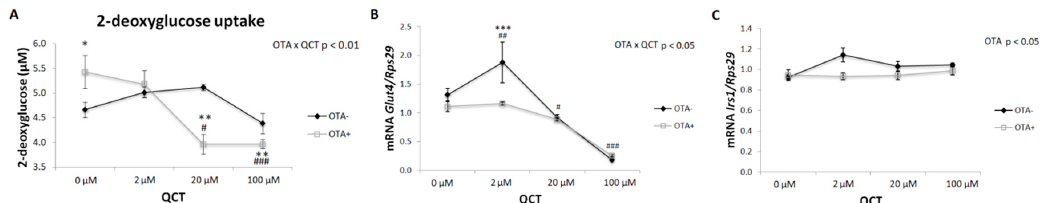
Figure 5. Insulin-stimulated glucose uptake by differentiated primary rat preadipocytes cultured with (OTA+) or without the addition of ochratoxin A (OTA-) in cell culture medium and with the addition of quercetin (QCT) at various concentrations ( A ). 2-deoxyglucose uptake was determined using a commercially available kit. The gene expression of glucose transporter 4 ( Glut4 ; B ) and insulin receptor substrate 1 ( Irs1 ; C ) was determined by real-time PCR. Data were normalized to the gene expression of 40S ribosomal protein S29 ( Rps29 ), the expression of which was not altered by the treatments. The results, presented as mean ± mean error (SEM), were analyzed by two-way ANOVA with factors QCT and OTA, followed by Bonferroni post-hoc test. The level of statistical significance considered for factor OTA was * p < 0.05; ** p < 0.01; *** p < 0.001, and for factor QCT # p < 0.05; ## p < 0.01; ### p < 0.001.